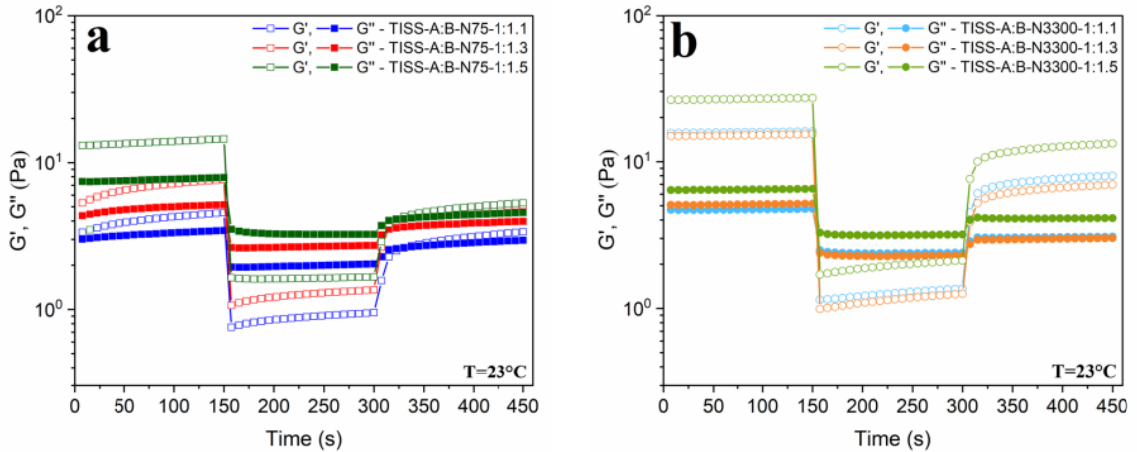
Figure 10. Three-step time test for TISS paints, prepared with fluoropolymer binder L200 and various concentrations of two catalysts: ( a ) Desmodur N75 and ( b ) Desmodur N3300, respectively: 1st step: constant low deformation in linear viscoelastic range; 2nd step: constant high deformation in the range of destructive conditions; 3rd step: constant low deformation, similar as in 1st step.